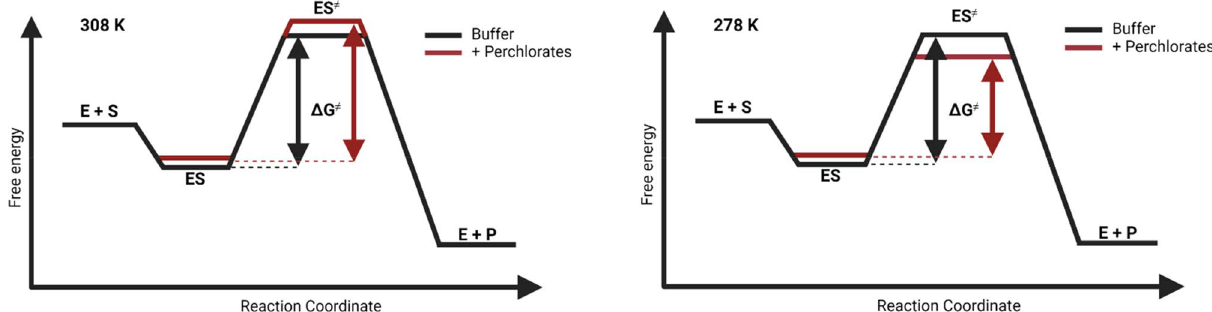
Figure 2. Schematic representation of the free energy changes across α-chymotrypsin’s reaction coordinate. The reaction coordinate of α-chymotrypsin at 308 and 278 K in buffer (black) and in the presence of perchlorate salts (red). Created in